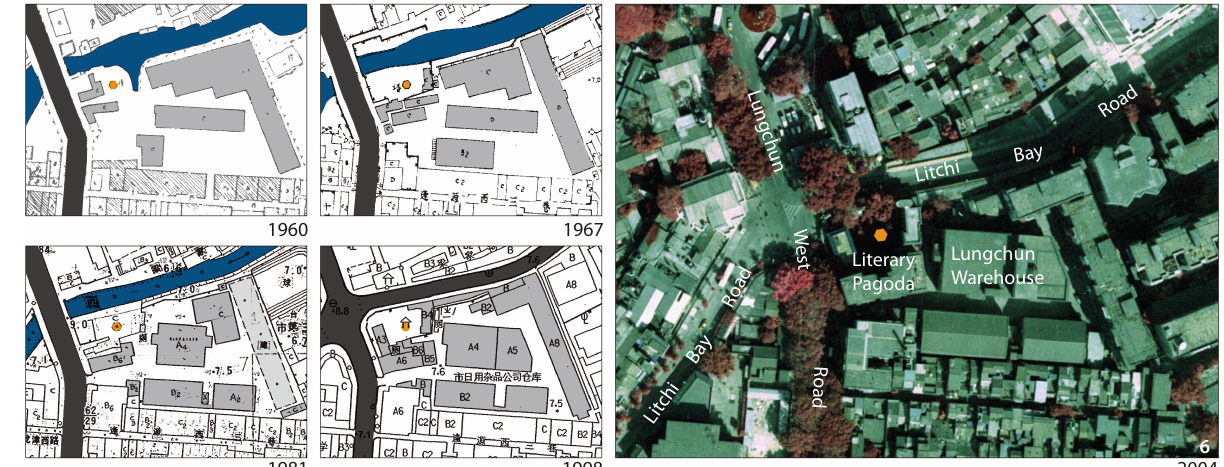
Figure 6 The transition of the Litchi Bay canal, Sai Kwan Literary Pagoda and Lungchun Warehouse during 1960–2004 (Source: Urban Planning Bureau of Liwan